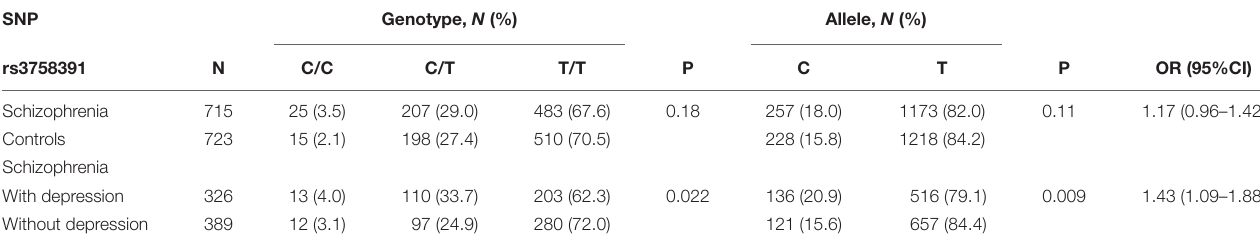
TABLE 1 | Distribution of rs3758391 genotype and allele in schizophrenia and controls, and schizophrenia with or without depression. SNP Genotype, N (%) Allele, N (%)